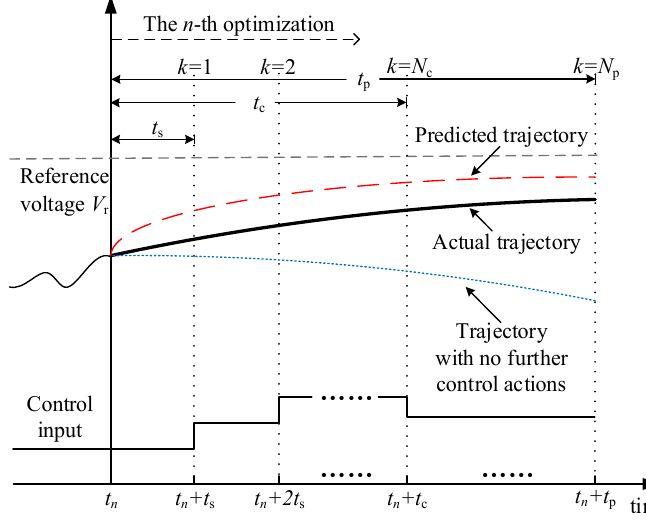
Figure 1. The principle of model predictive control.